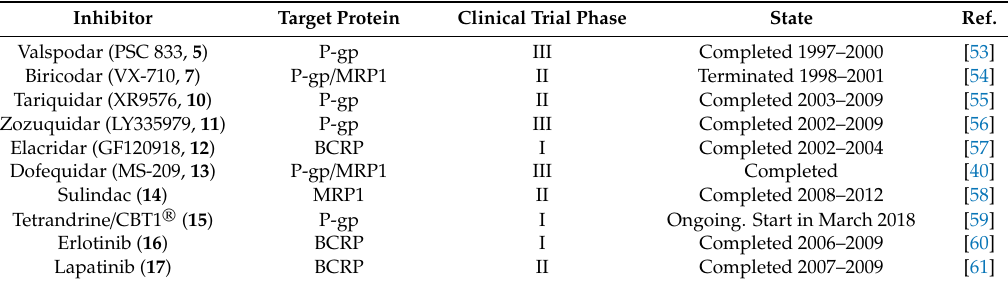
Table 1. Selected ABC protein inhibitors evaluated in clinical